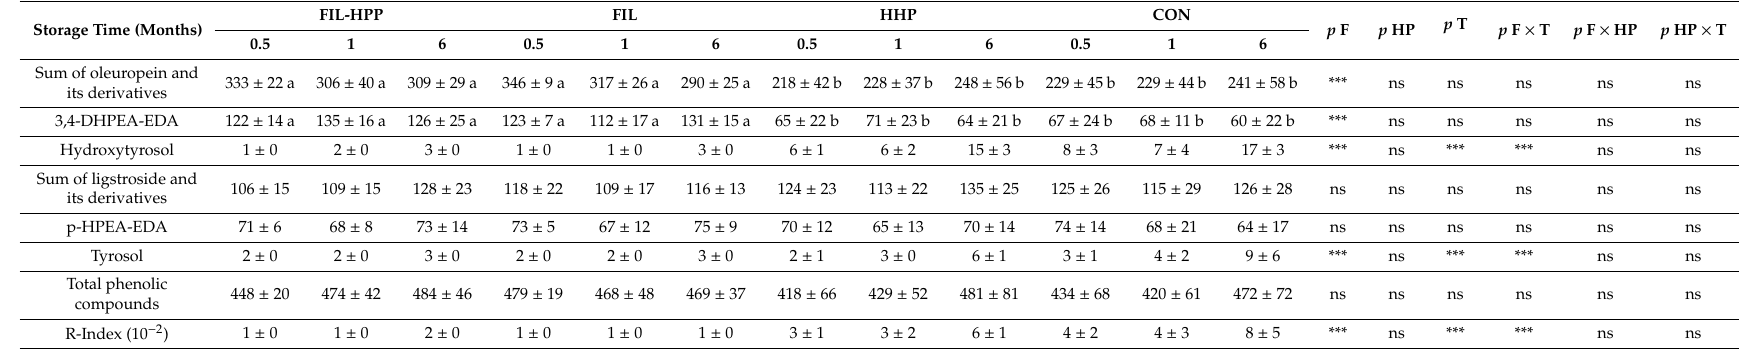
Table 4. Mean values and standard deviation of the phenolic compound content for the four specimens of olive oil samples during storage. Storage Time